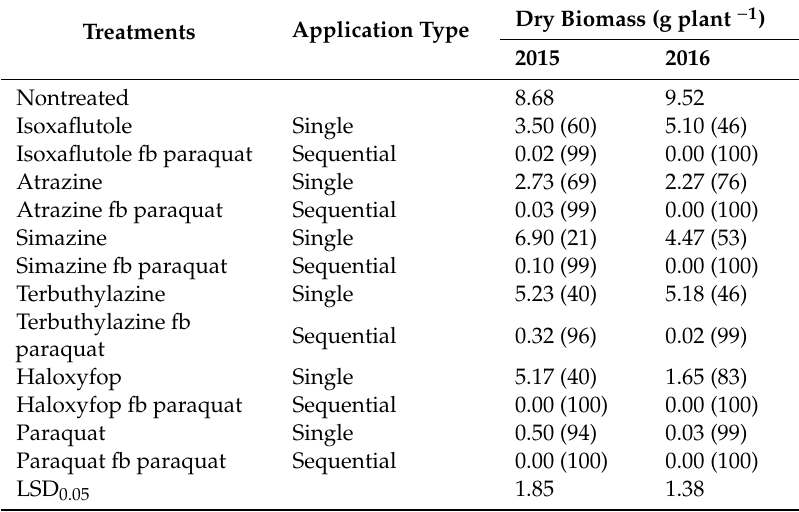
Table 4. E ff ect of single and sequential herbicide treatments on weed biomass at 42 d after treatment of flowering Echinochloa colona in pots over two separate experiments conducted in 2015 and